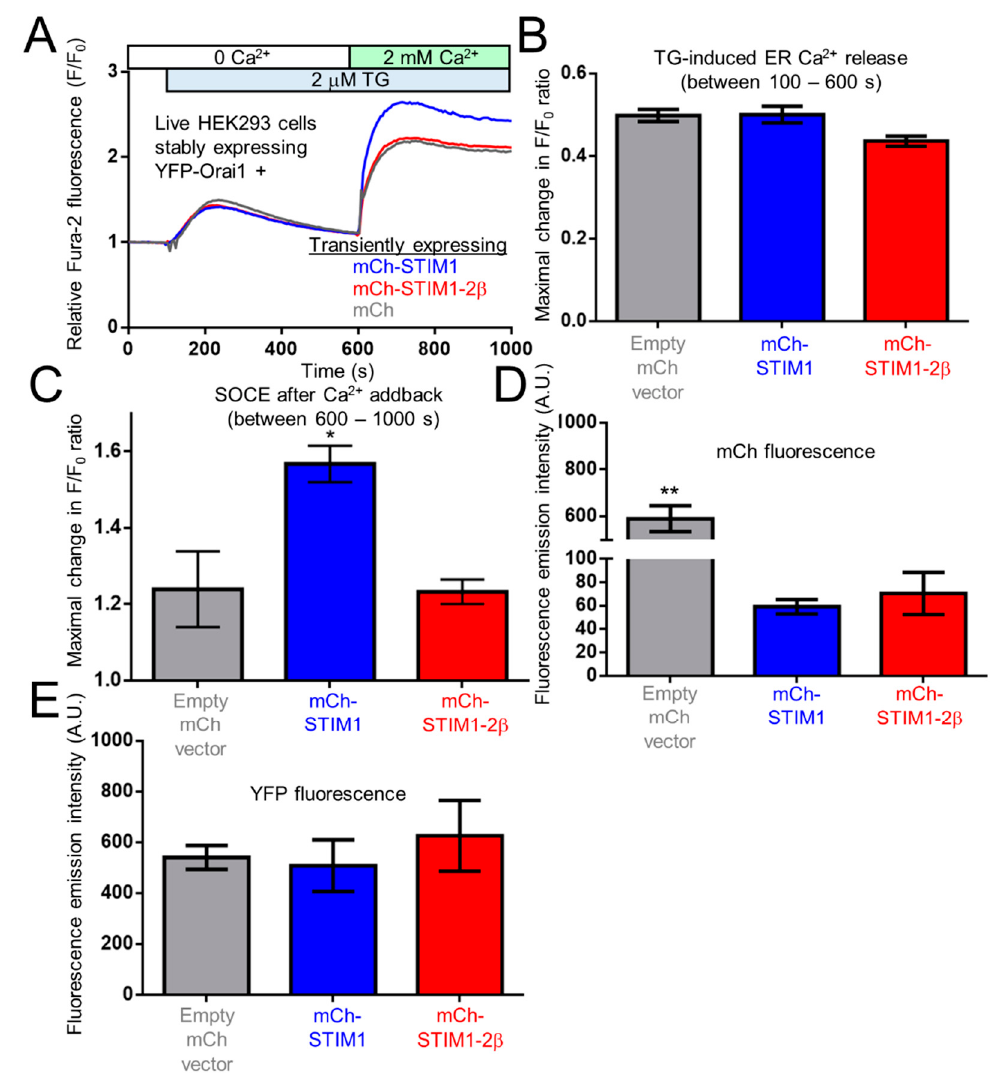
Figure 7. Fura-2 cytosolic Ca 2+ assessment of full-length STIM1 and STIM1-2 β function in SOCE. ( A ) Representative Fura-2 ratiometric fluorescence traces reporting relative changes in cytosolic Ca 2+ of mCh-STIM1 (blue), mCh-STIM1-2 β insert (red) and empty mCh-vector (grey) expressing HEK293 cells also stably expressing yellow fluorescence protein (YFP)-Orai1. Cells were initially bathed in Ca 2+ -free buffer. The relative change in Fura-2 fluorescence was monitored after 2 µ M TG and subsequently 2 mM CaCl 2 additions to the external medium. ( B ) Maximal ER Ca 2+ release (i.e., F/F 0 taken after TG addition in 0 mM external CaCl 2 . ( C ) Maximal SOCE taken after addition of 2 mM CaCl 2 to the external medium. ( D ) Maximum mCh fluorescence emission of cell suspensions using an excitation wavelength of 565 nm. ( E ) Maximum YFP fluorescence emission of cell suspensions using an excitation wavelength of 490 nm. Data in ( B – E ) are means ± SEM of n = 4 separate transfections. In ( C ) * p < 0.05 and ( D ) ** p < 0.01 using One-way ANOVA and Tukey’s multiple comparisons test.